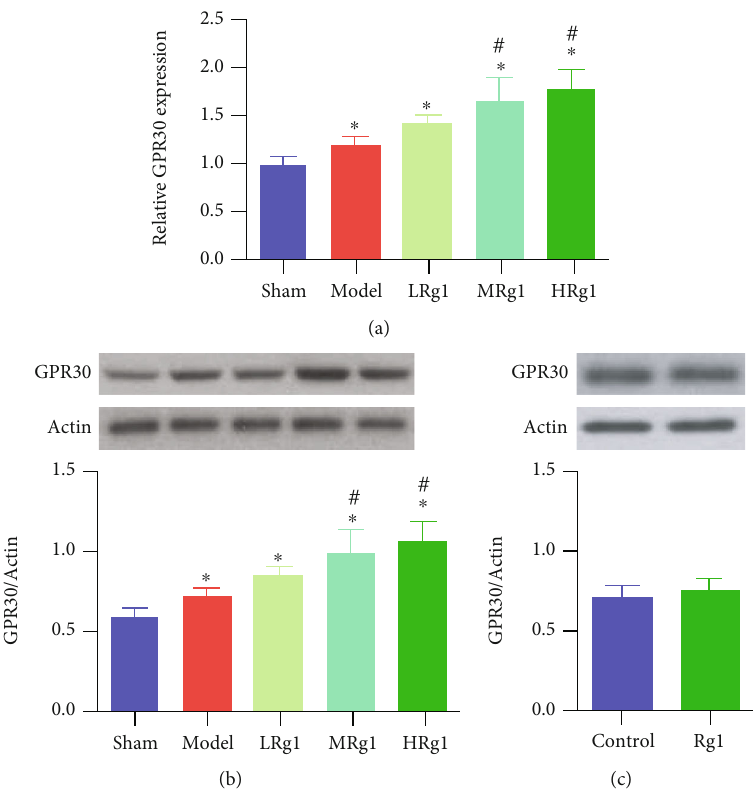
Figure 3: Ginsenoside Rg1 promoted the hippocampal GPR30 expression in the BCAS model animals but had no e ff ect in normal animals. (a) GPR30 mRNA expression; (b) GPR30 protein expression in the hippocampus of mice receiving BCAS and ginsenoside Rg1; (c) GPR30 protein expression in the hippocampus of normal mice receiving ginsenoside Rg1. ∗ P < 0 : 05 , vs. sham; # P < 0 : 05 , vs. the model group ( N = 5 in each group).